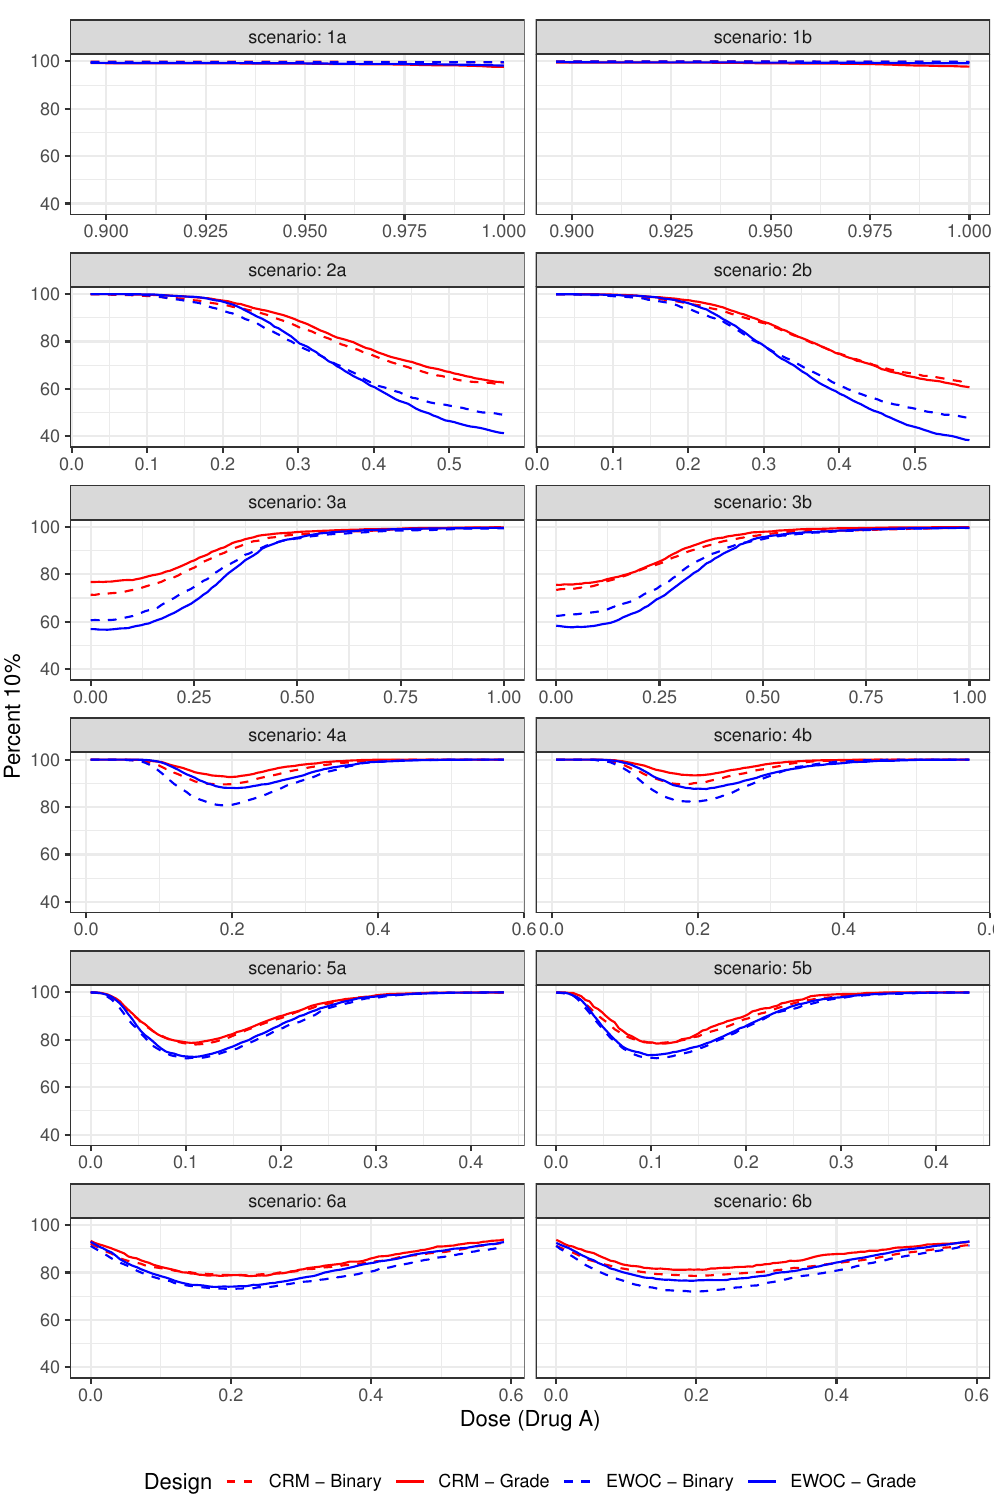
Figure 3. Pointwise percent of MTD recommendation for p = 0.1 under Scenarios